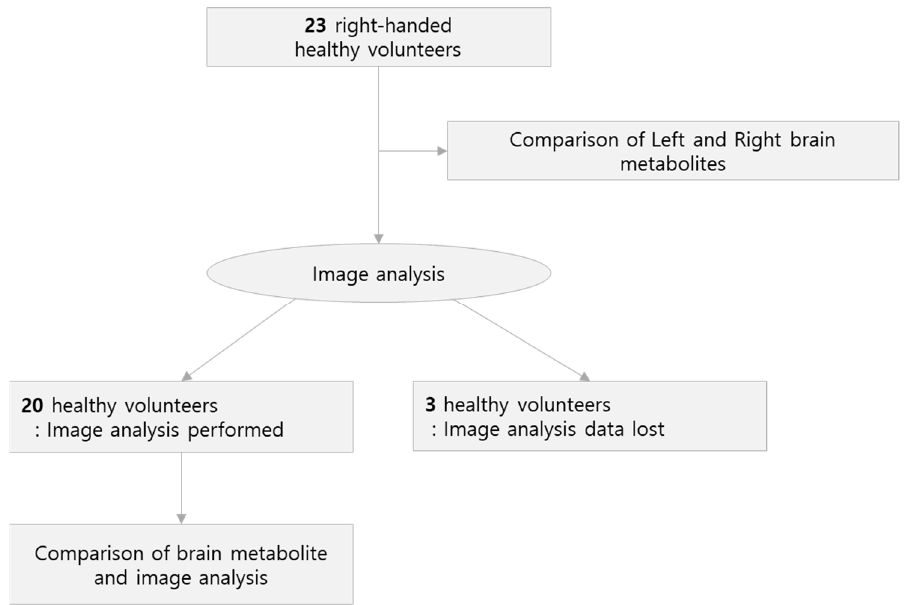
Figure 1. Diagram flow of participant inclusion.